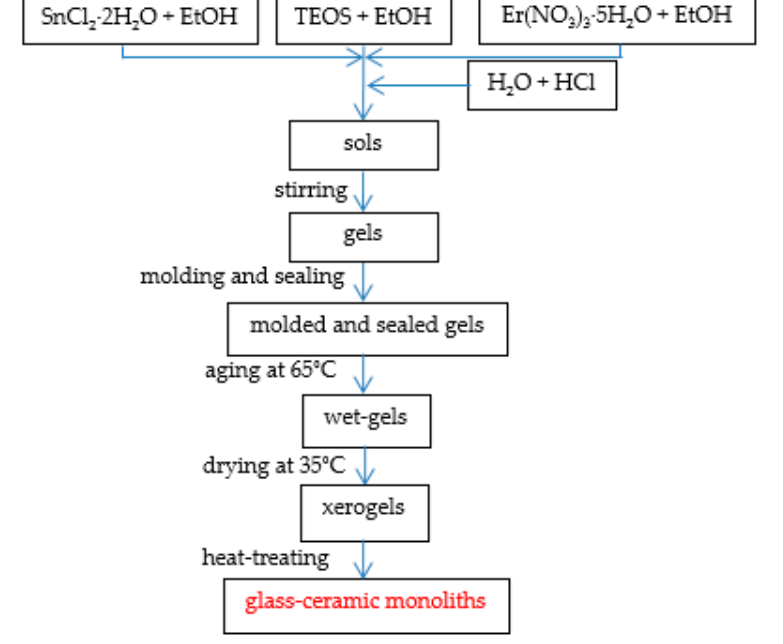
2 -10SnO 2 :0.5Er 3+ monoliths.